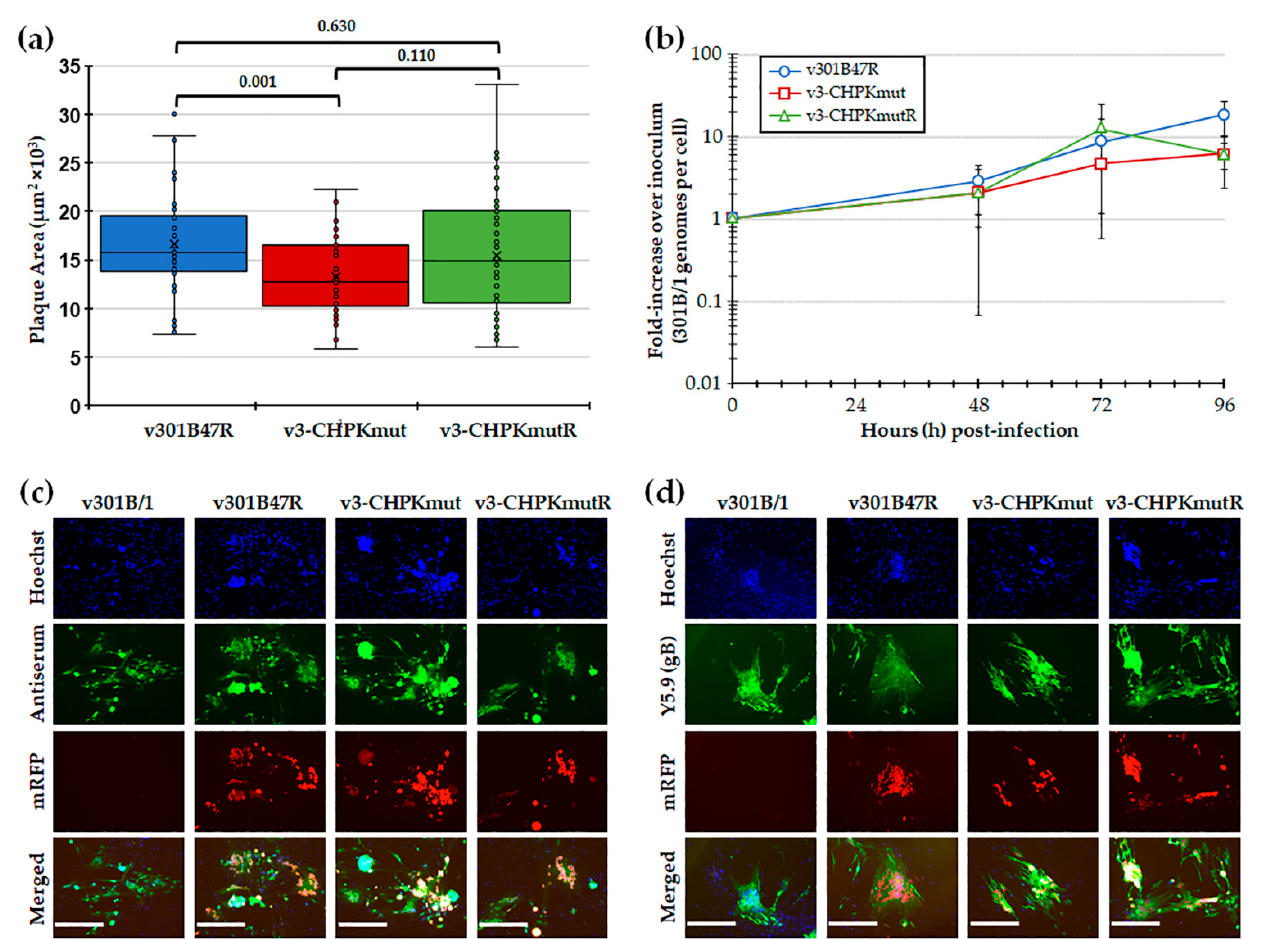
Figure 2. Replication in tissue culture cells. ( a ) Mean plaque areas ( n = 50) of viruses reconstituted from r301B47R, v3-CHPKmut, and v3-CHPKmutR were measured and the results are shown as box- and-whisker plots. Statistically significant differences between the different viruses were determined with Kruskal–Wallis tests (one-way non-parametric ANOVA), followed by multiple comparison tests. There was a significant difference ( p = 0.001) between v301B47R and v-3CHPKmut using an independent samples Kruskal–Wallis test. No significant difference ( p = 0.630) was determined between v301B47R, v-3CHPKmut, and v-3CHPKmutR. ( b ) Multi-step replication kinetics was used to measure virus replication in CEC cultures. The mean fold-change in viral DNA copies over the inoculum is shown for each virus and time point. Except for an effect of significant changes in viral DNA replication over time (T; p = 0.001), there were no differences in virus replication between viruses (V; p = 0.308) or in their interaction (V × T; p = 0.19) ( p > 0.05, two-way ANOVA, Tukey, n = 6). ( c ) Representative plaques for v301B/1, v301B47R, v3-CHPKmut, and v3-CHPKmutR used for plaque size assays are shown. Plaques were stained with polyclonal chicken anti-GaHV-3 antibody and goat anti-chicken-IgY Alexa488 (green) was used as a secondary antibody to identify plaques. Fluorescent expression of mRFP (red) was directly visualized and cells were counterstained with Hoechst 33,342 to visualize nuclei. ( d ) Representative plaques for v301B/1, v301B47R, v3-CHPKmut, and v3-CHPKmutR were stained with monoclonal mouse anti-gB IgG1 antibody (Y5.9) and goat anti-mouse-IgG Alexa488 (green) was used as a secondary antibody to show 301B/1 specificity of plaques. Fluorescent expression of mRFP (red) was directly visualized and cells were counterstained with Hoechst 33,342 to visualize nuclei. Scale bars represent 200 µ